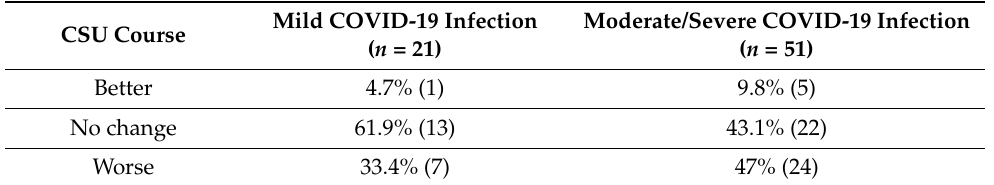
Table 3. CSU course during COVID-19 mild or moderate-severe infection represented as percent and number of patients.